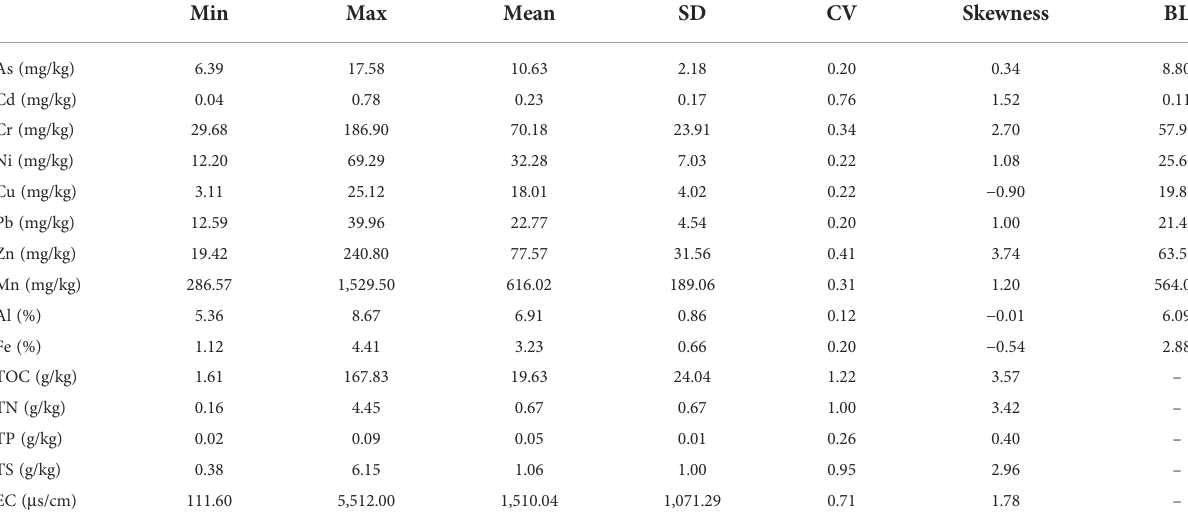
TABLE 1 Summary of the element contents and electrical conductivity (EC) in Liaohe